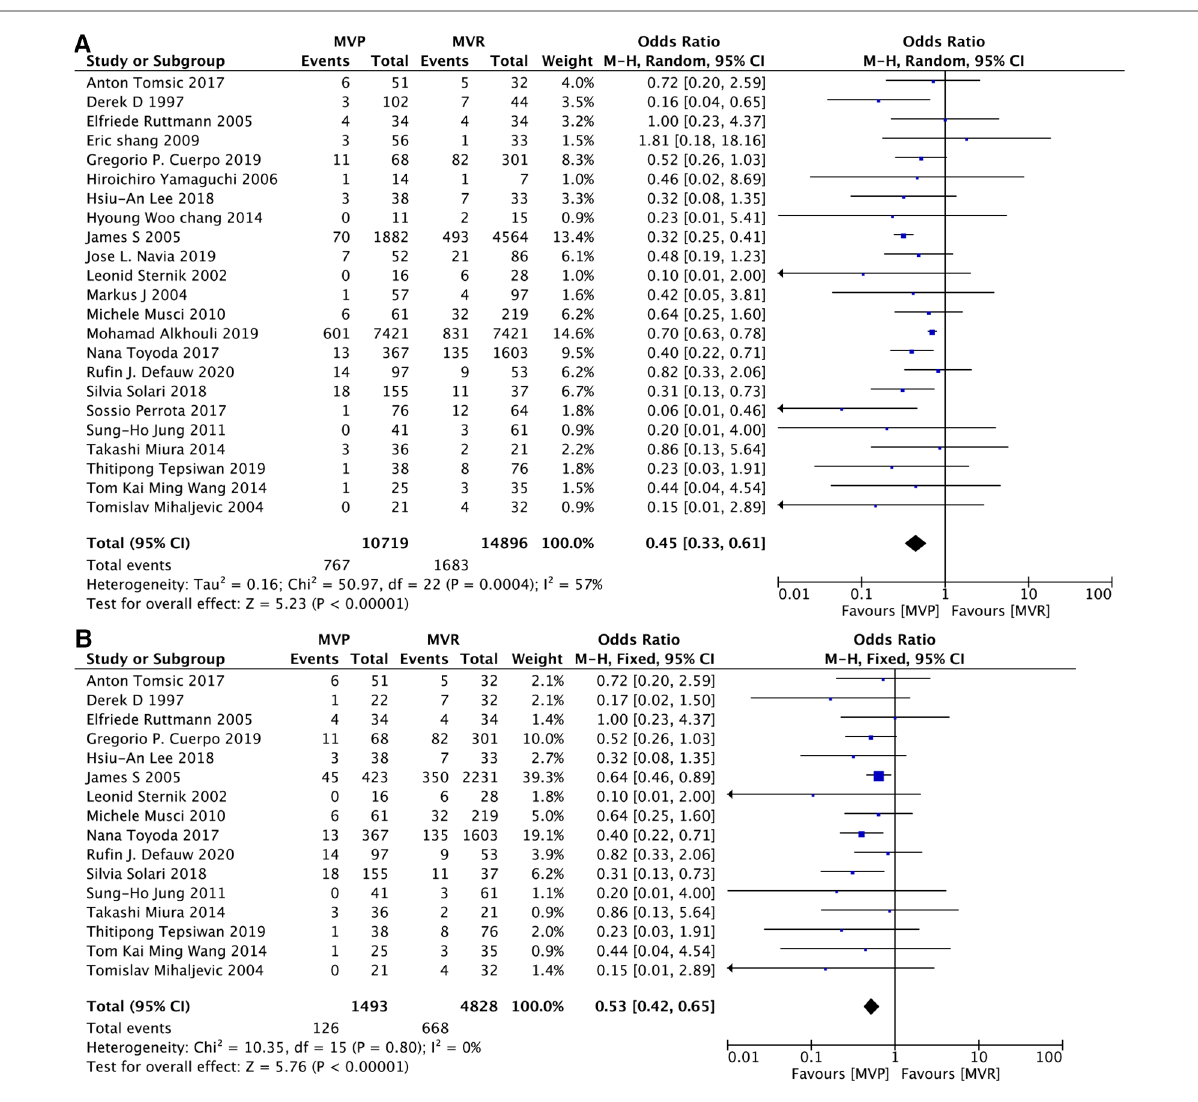
FIGURE 2 Meta-analysis for early mortality: ( A ) MVP vs. MVR; ( B ) MVP vs. MVR (active IE); MVP, mitral valve plasty; MVR, mitral valve